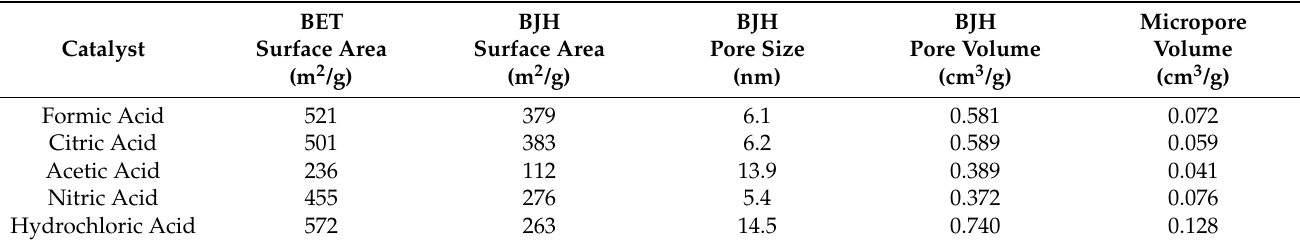
Table 2. Textural properties of the mesoporous carbons synthesized using the soft templated or- ganic-organic self-assembly of resorcinol and formaldehyde in the presence of various acids.